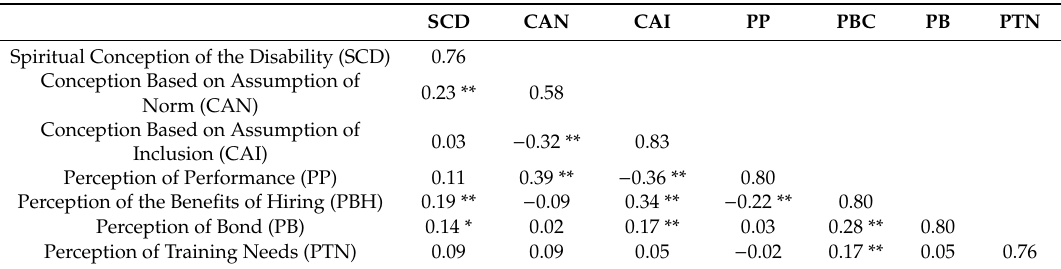
Table 2. Discriminant